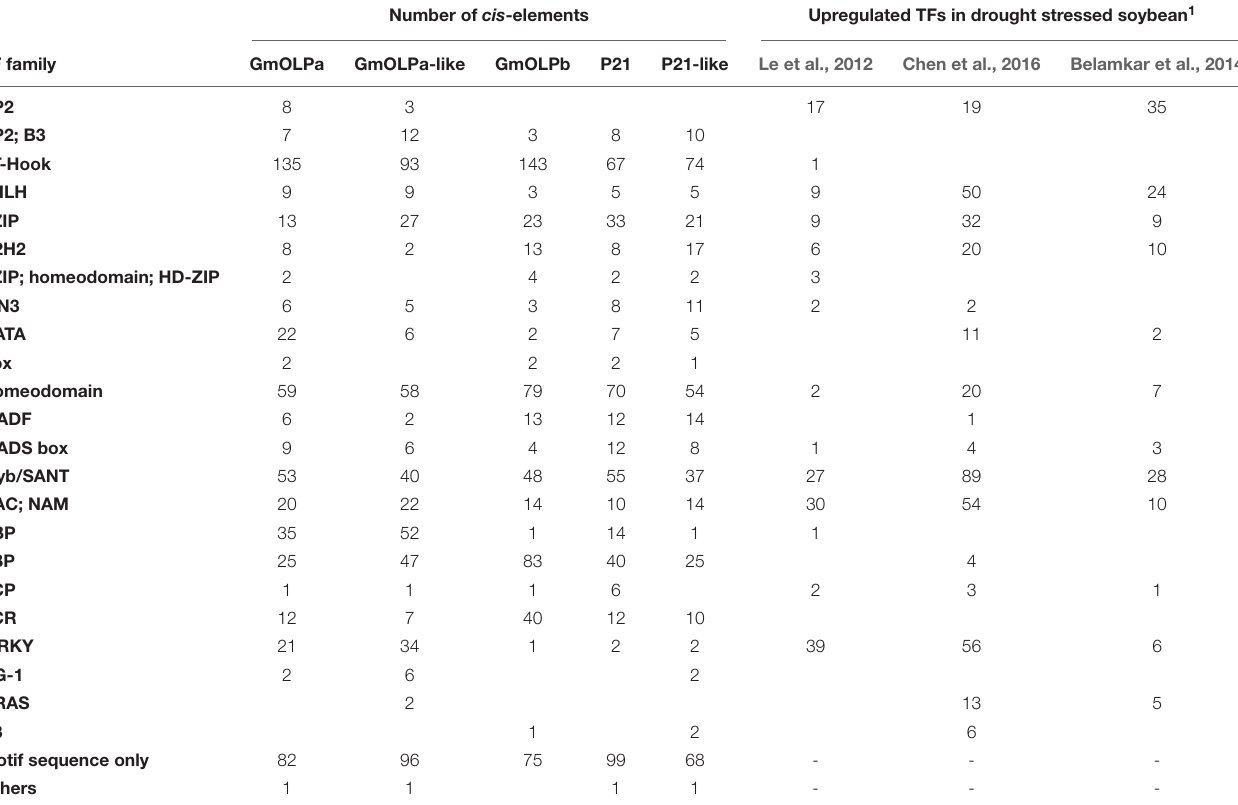
TABLE 5 | Transcription factor binding sites (TFBS) identified in the promoter sequences of soybean osmotin genes and the number of TFs upregulated in expression data. Number of cis -elements Upregulated TFs in drought stressed soybean